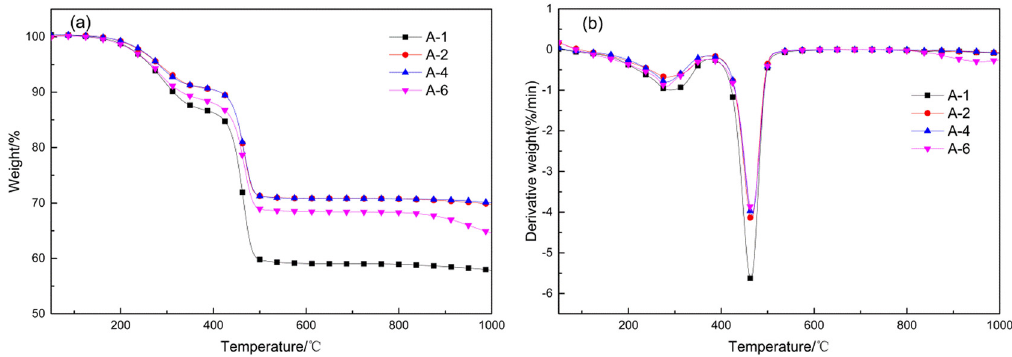
Figure 4: TG ( a ) and DTG ( b ) curves for composites.